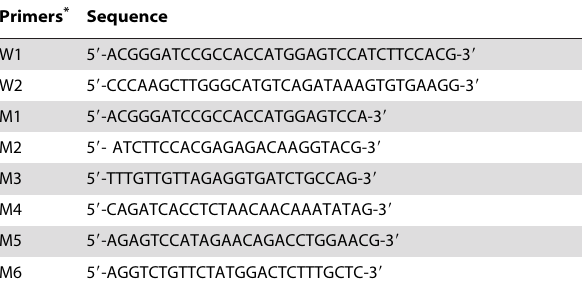
Table 1. Primers for